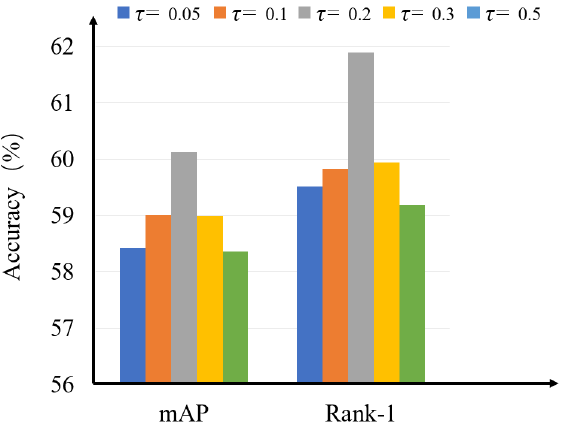
Figure 5. The influence of the scalar temperature parameter τ in Rank-1 accuracy and mAP